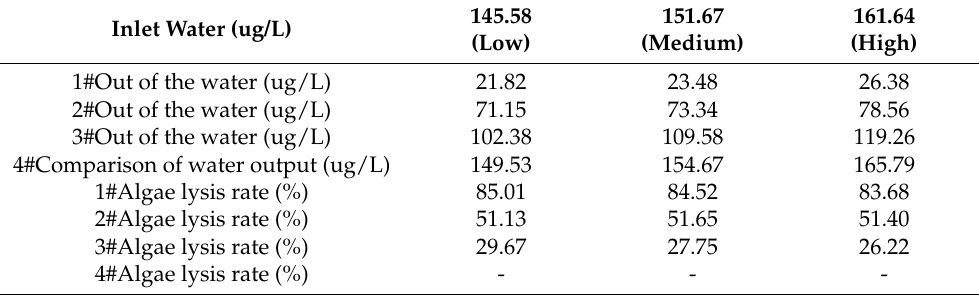
Table 2. The algicidal efficiency of three addition methods of white rot fungi on Turpin FACHB-507. Inlet Water (ug/L)